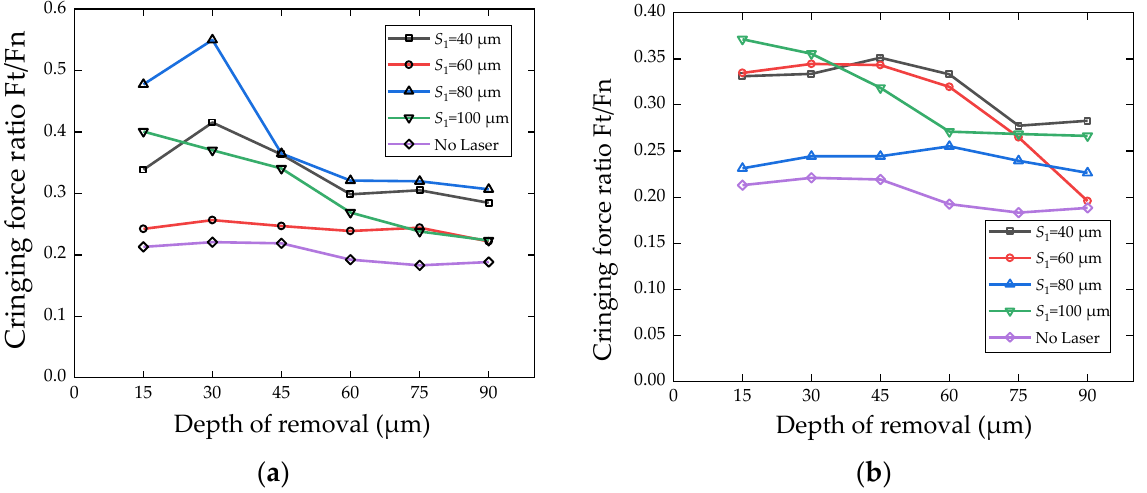
Figure 10. The relationship between the normal grinding force the total material removal thickness ( N = 40). ( a ) k = 49 kHz. ( b ) k = 20 kHz.